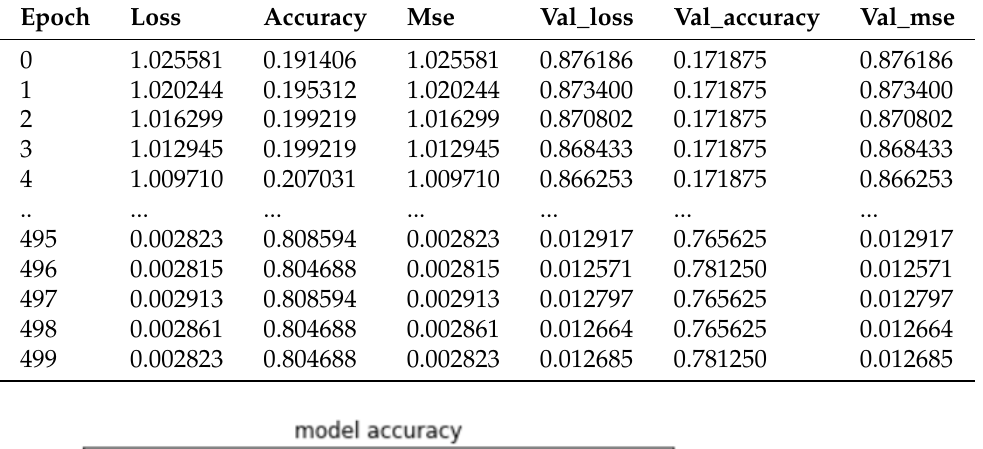
Table 13. RBFNN accuracy curve.